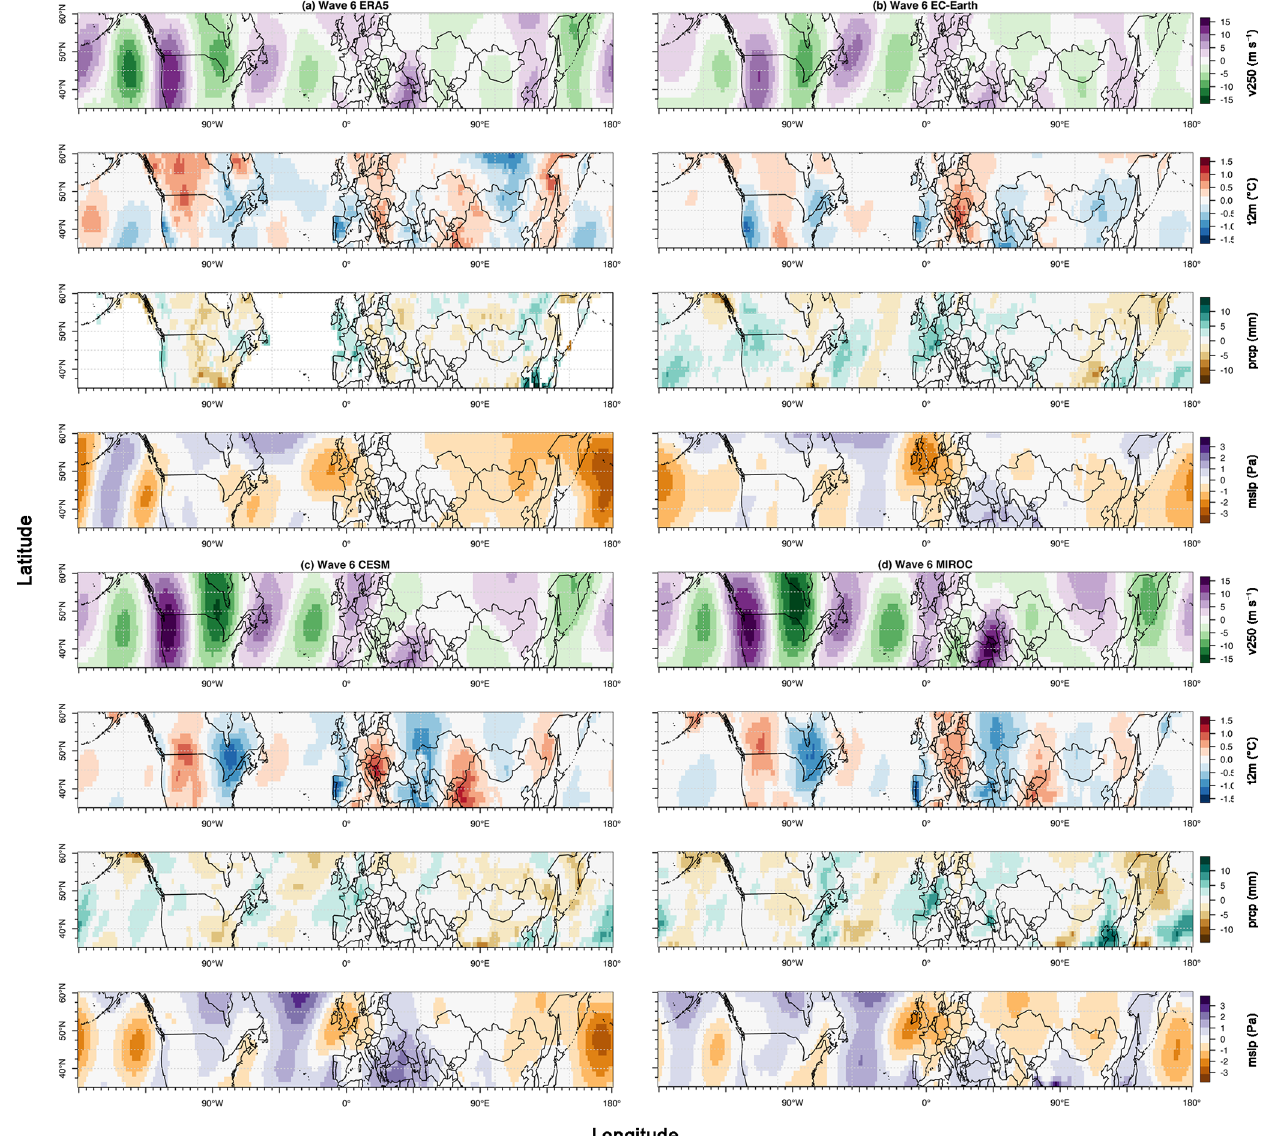
Figure B4. Composite anomaly plots of weeks with high-amplitude wave-6 episodes for meridional wind velocity at 250hPa (v250, absolute field), near-surface temperature (t2m, anomaly), precipitation (prcp, anomaly), and sea level pressure (mslp, anomaly) in ERA5 (a) , EC- Earth (b) , CESM (c) , and MIROC (d) based on the AISI control runs.